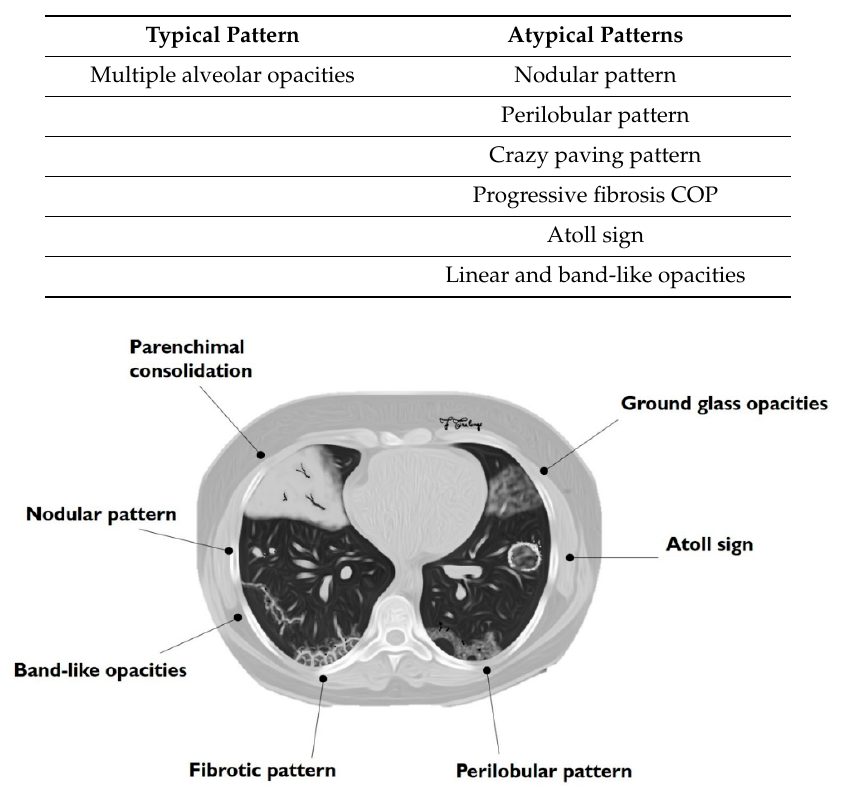
Table 1. Patterns of COP.